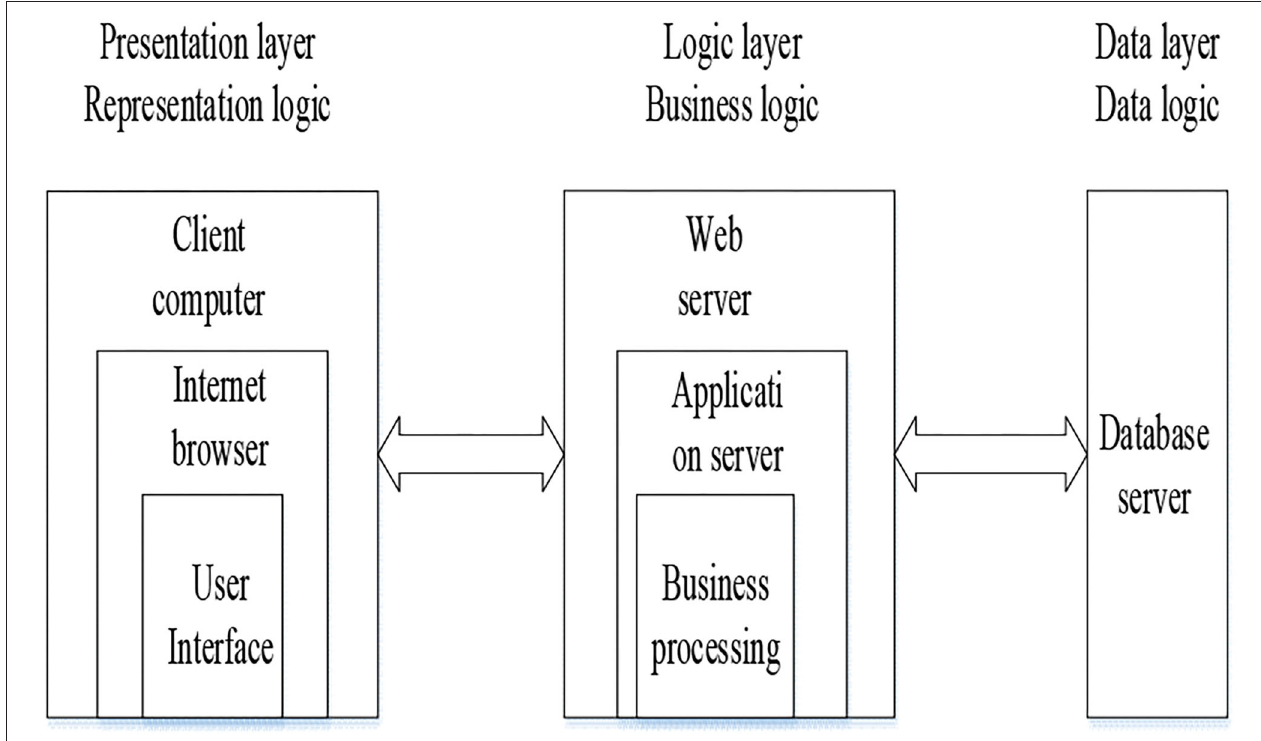
FIGURE 1 | B/S structure